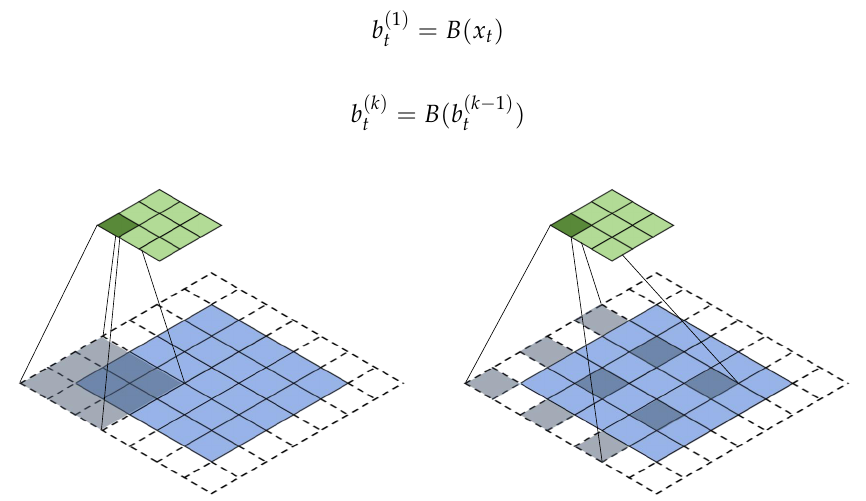
Figure 4. Normal CNN ( left ) acts on a continuous position of the input matrix and continuously slides to do convolution and pooling. The dilated CNN ( right ) adds a dilation width to the filter. When it acts on the input matrix, it skips the input data in the middle of all the dilation width, and the size of the filter matrix itself remains the same, so the filter achieves a wider input.